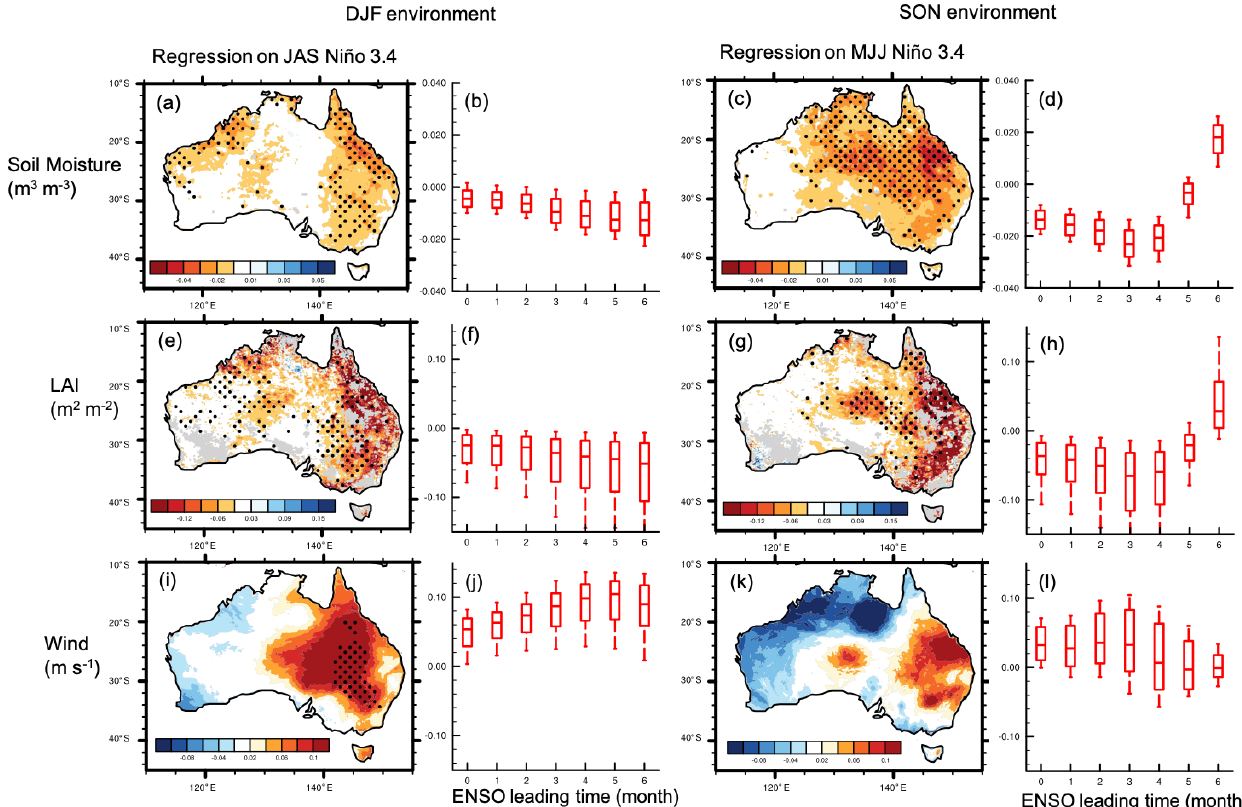
Figure 10. Regression of anomalies in seasonal LAI, soil moisture, and surface wind speed in (a, b, e, f, i, j) December–February (DJF) and (c, d, g, h, k, l) September–November (SON) upon Niño 3.4. (a, c, e, g, i, k) Regression coefficient between (a) LAI, (e) soil moisture, and (i) surface wind speed during DJF and Niño 3.4 during antecedent July–September (JAS) (ENSO leading environmental conditions for 5 months), and SON (c) LAI, (g) soil moisture, and (k) surface wind speed during SON and Niño 3.4 during antecedent May–July (MJJ) (ENSO leading environmental conditions for 4 months). Figure elements are the same as Fig. 9a–h.